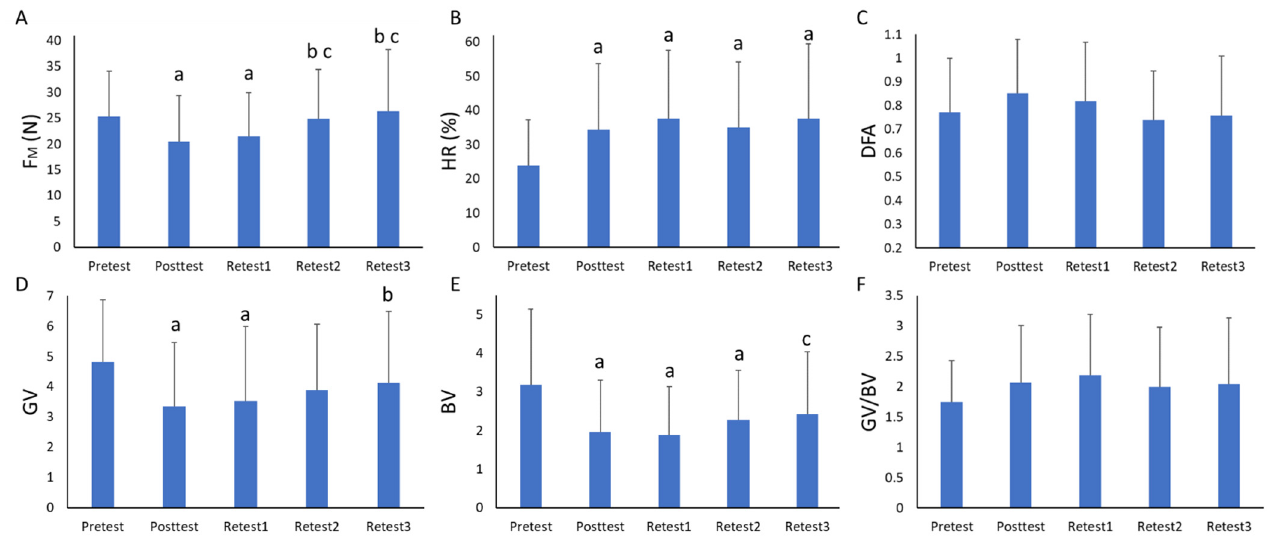
Figure 4. Average error values in all the tests calculated in the study and the pair comparisons results extracted from the repeated measures ANOVA. ( A ) refers to the Force magnitude values; ( B ) refers to the Hit ratio values; ( C ) refers to the Detrended Fluctuation values; ( D ) refers to Good Variability values; ( E ) refers to Bad Variability values; and ( F ) refers to the Good and Bad variability ratio. a = significant differences compared with the pretest; b = significant differences compared with the posttest; c = significant differences compared with retest1.